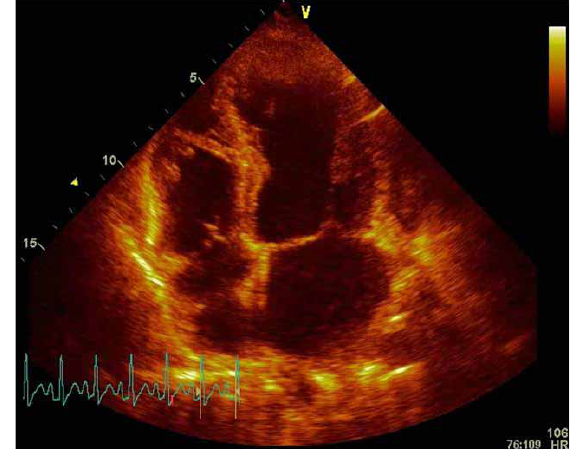
Figure 3. First echocardiographic examination.